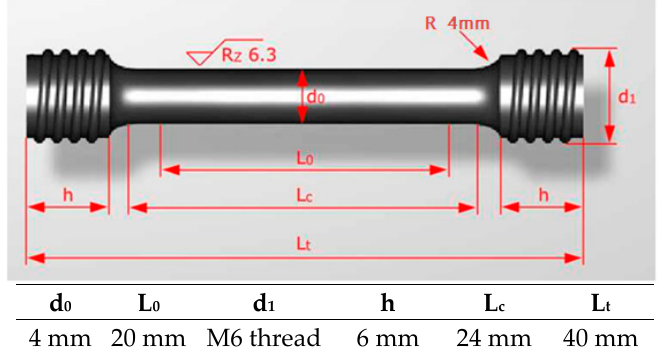
Figure 2. Dimensions of tensile samples according to DIN 50125 M6.